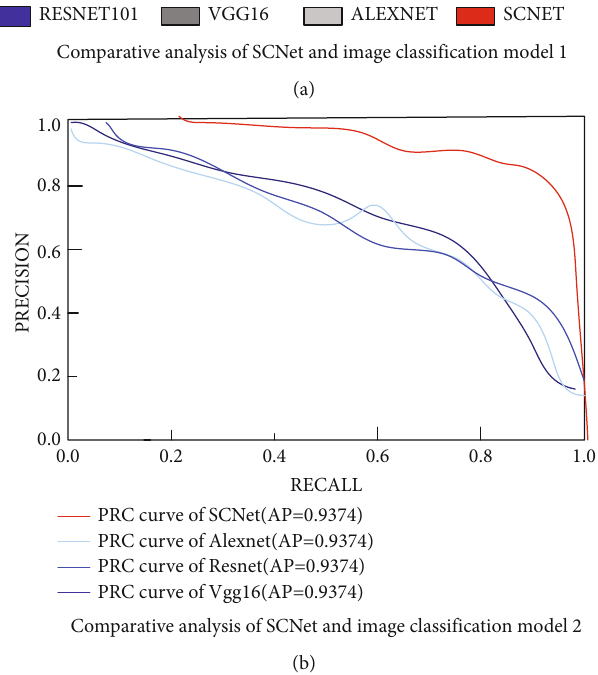
Figure 8: Comparative analysis of SCNet and image classi fi cation